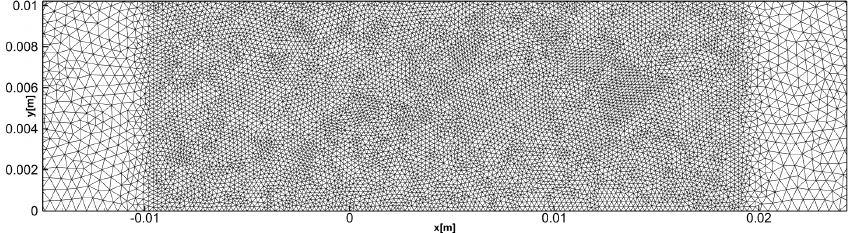
Figure 3. Close-up view of the FV mesh in the space region occupied by the water body for the solution CFD